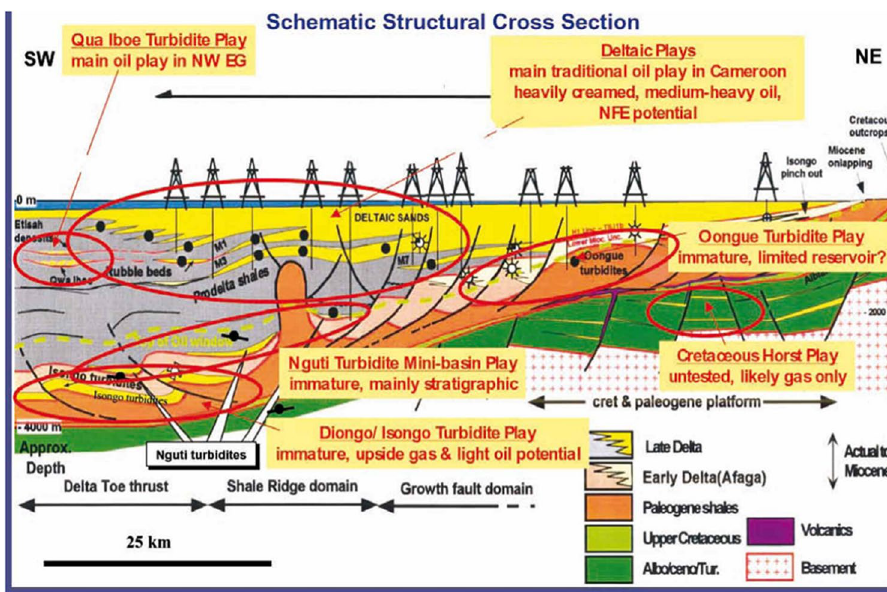
Fig. 3 Cross section through the RDR Basin showing traps and plays (SNH